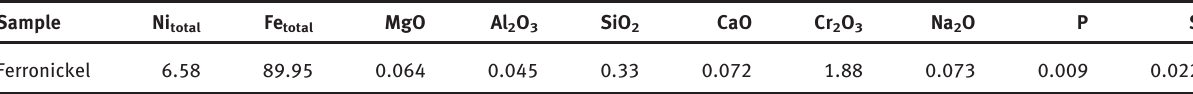
Table 3: Chemical compositions of ferronickel (mass%).